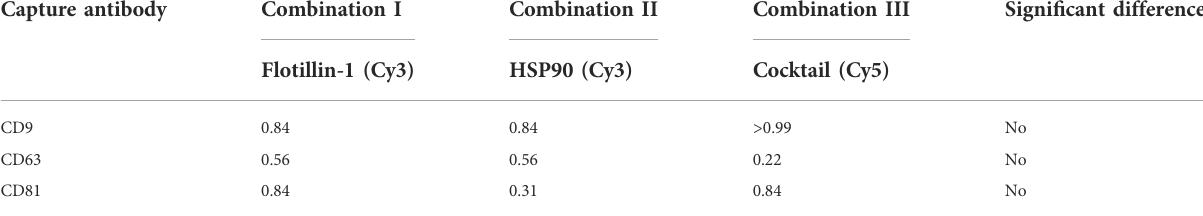
TABLE 2 p -values from simultaneously measured antibody compositions with Cy5- and Cy3-labeled molecules. Capture antibody Combination IV Combination V Signi fi cant difference Cocktail (Cy5)/ fl otillin-1 (Cy3) Cocktail (Cy5)/HSP90 (Cy3) CD9 0.16 0.31 CD63 0.56 0.69 CD81 0.03 0.03 Yes